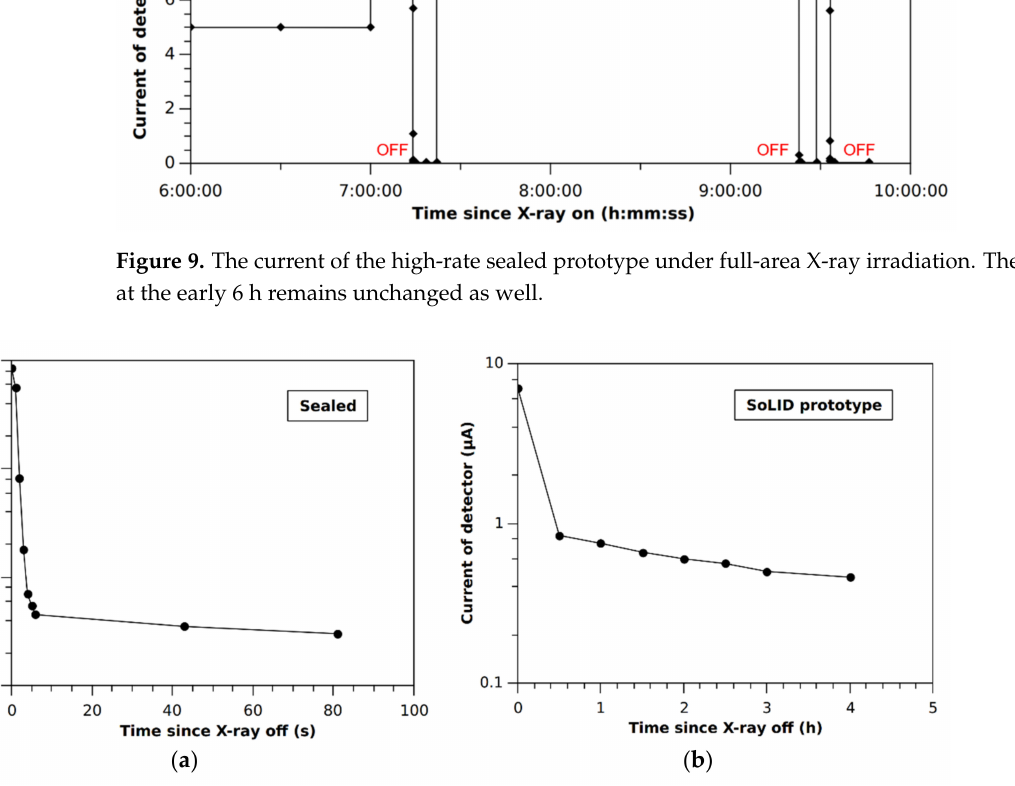
Figure 10. The current decay comparison since the X-ray was shut down. ( a ) The high-rate sealed MRPC; ( b ) the SoLID